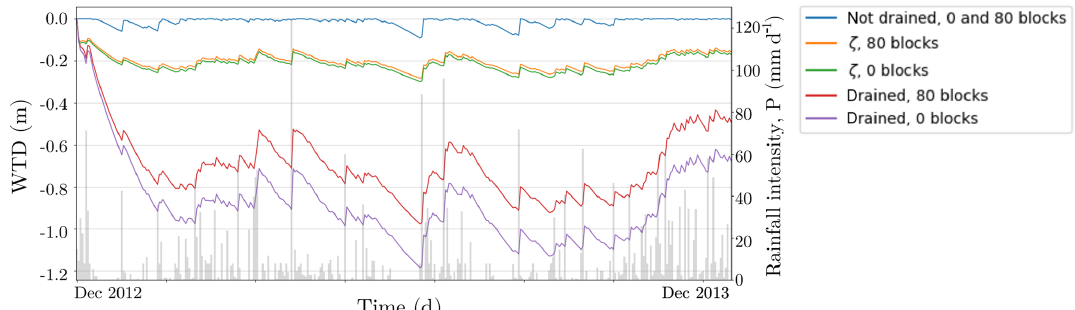
Figure 10. Simulated daily WTD for two sites (drained and natural, see Fig. 7 for the exact locations) within the peatland area and the average WTD, ζ . The same period (December 2012–December 2013) was simulated without any blocks (green and purple lines) and with the 80 optimized blocks (orange and red lines). The spatial average ζ for b = { 0 , 80 } is shown in orange and green. There was no appreciable difference in WTD in the undrained area between different block configurations, and the WTD is shown by a single line (blue line). Daily rainfall intensity is shown as gray vertical lines (data from Pekanbaru